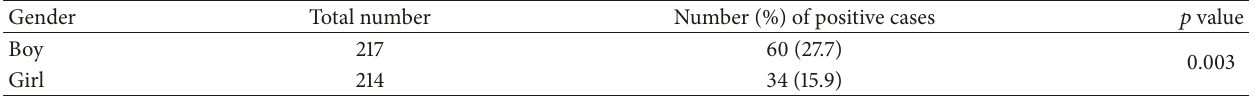
Table 1: Gender-dependent frequency of H. pylori infection among schoolchildren (aged between 6 and 18 years).